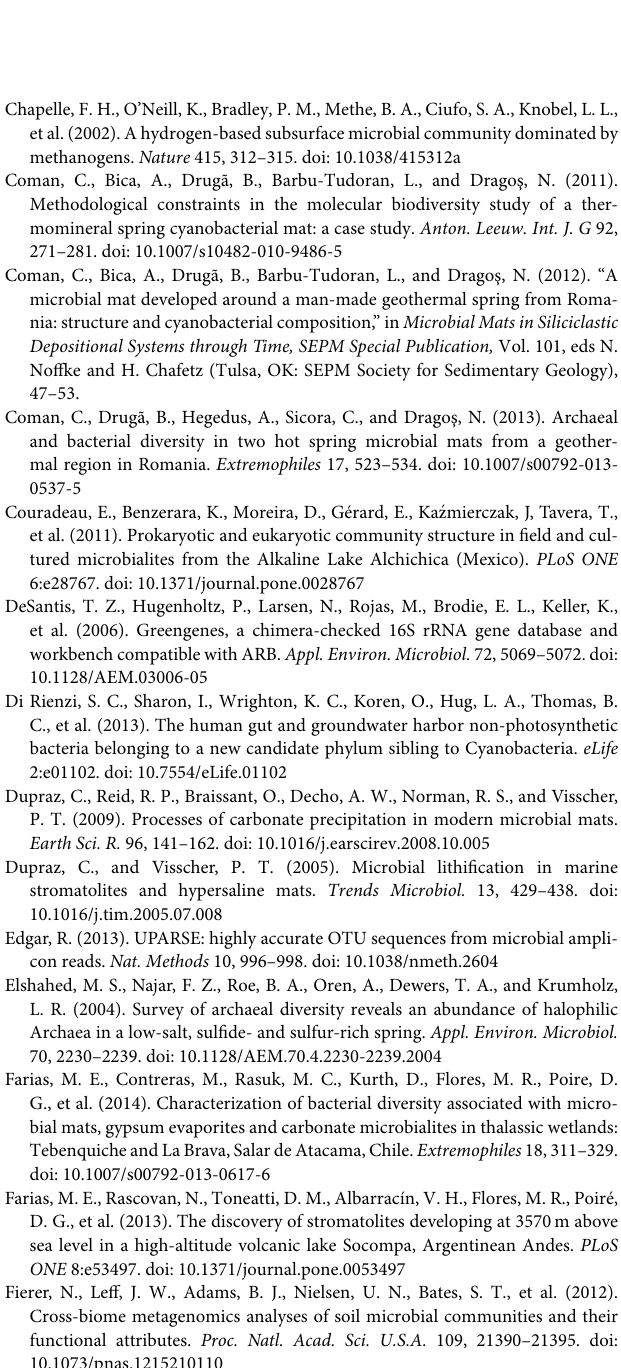
Supplementary Figure S1 | The phylogenetic placement of OTUs relative to known curated sequences deposited in the SILVA SSU Ref database (v115) using the ARB software package (Ludwig et al., 2004).